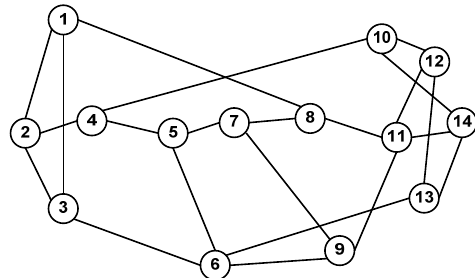
Figure 3. 14-node NSFNET.